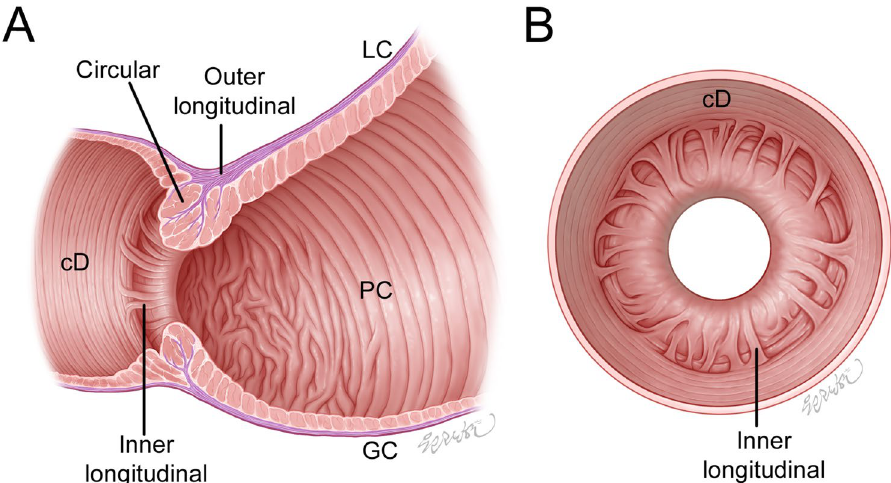
Figure 8. Schematic of the pyloric sphincter (PS) general pattern in a longitudinal section including the lesser curvature (LC) and greater curvature (GC). ( A ) and the duodenal aspect of the pyloric orifice ( B ). ( A ) The wall of the PS comprised three layers: outer longitudinal bundles, intermediate main circular and minor longitudinal bundles originating from the stomach, and inner longitudinal bundles connecting the PS to the duodenum. The longitudinal bundles that entered the PS were connected to the circular bundles of the PS. The inner longitudinal bundles were connected to the circular bundles of the duodenum (cD). The circular fibers of the PS on the LC side spread out to connect with the circular bundles of the aboral end of the pyloric canal (PC) on the GC side. The circular bundles in the aboral end of the PC adjacent to the PS were irregularly arranged. ( B ) The inner longitudinal bundles usually divided from the internal surface of the PS wall to connect to the adjacent cD in irregular and radial directions in the duodenal aspect of the pyloric orifice.